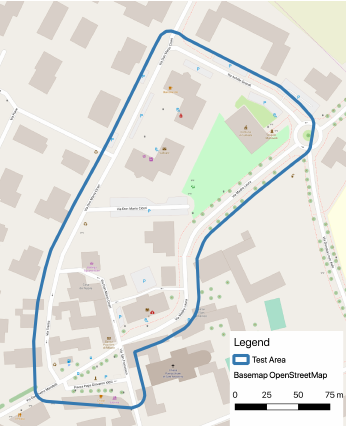
Figure 5. Location of the area (blue) used for the time test.